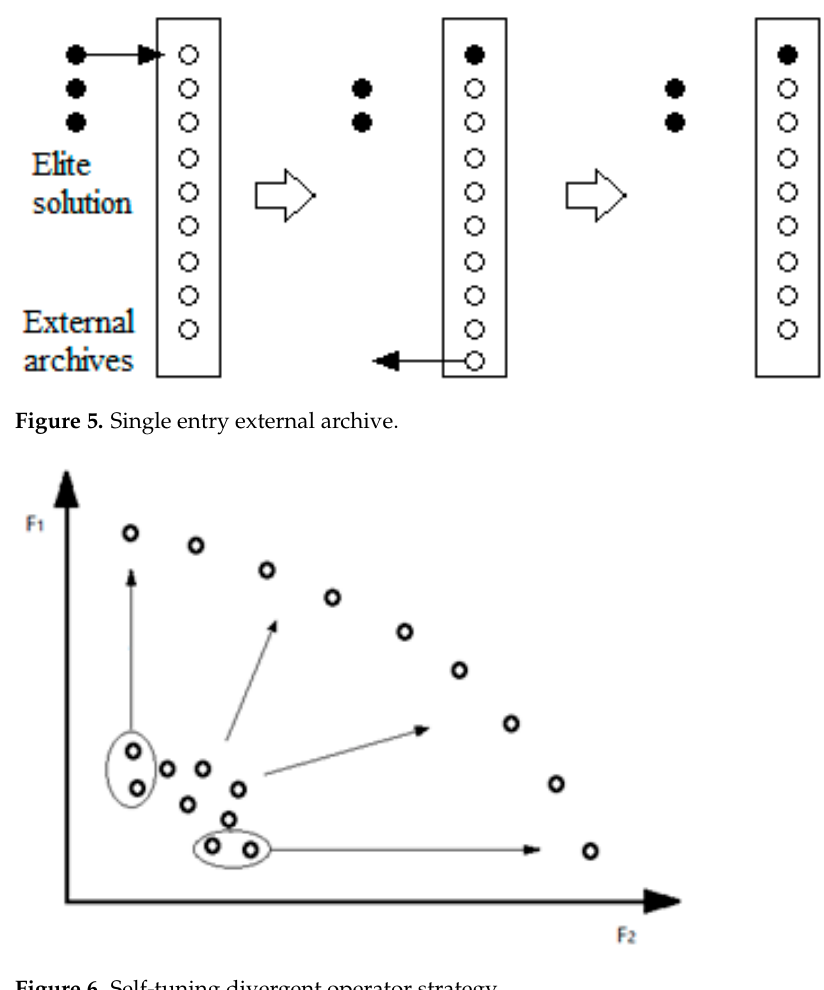
Figure 6. Self-tuning divergent operator Figure 6. Self ‐ tuning divergent operator strategy.